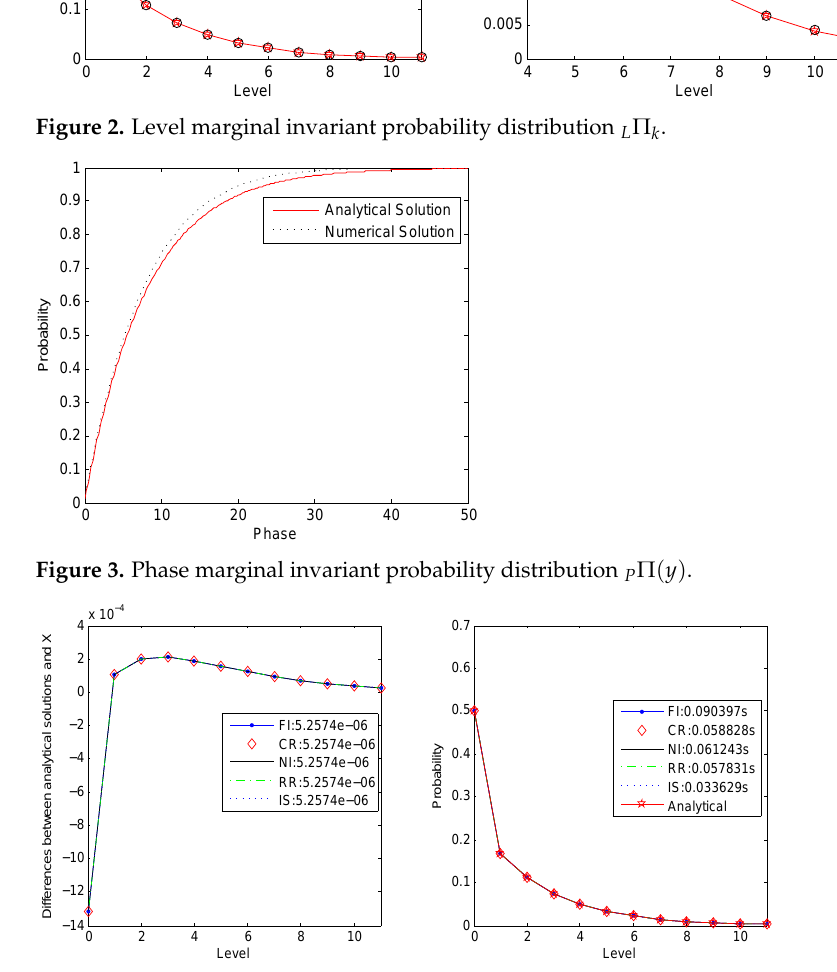
Figure 4. Difference among methods on level marginal invariant probability distribution L Π k